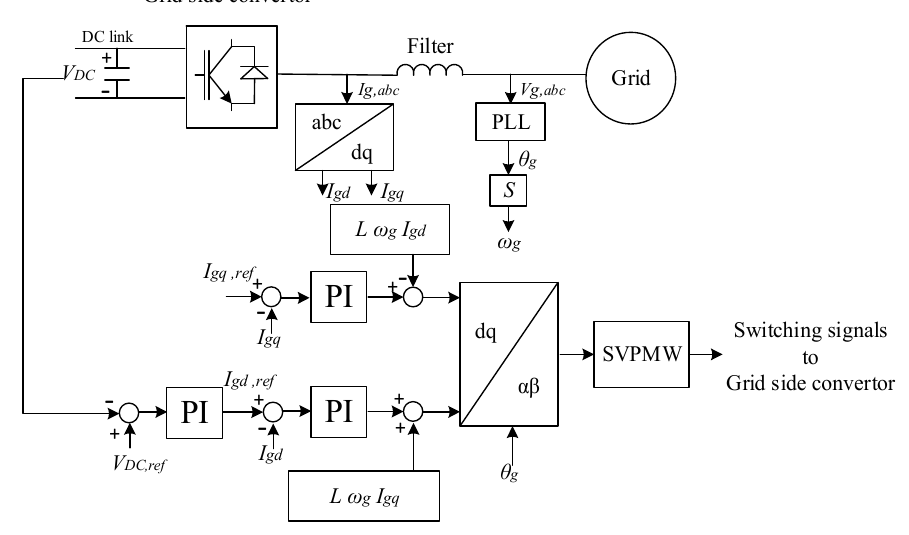
Figure 10. Control loops of a grid side converter with AC grid.